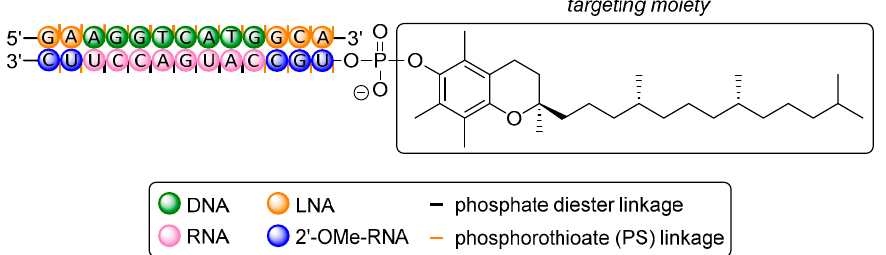
Figure 8. Structure of the α -TP-HDO conjugate designed to target the expression of OAT3 in BEMEC.